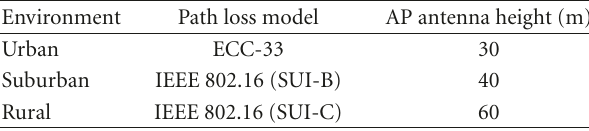
Table 2: Propagation loss models